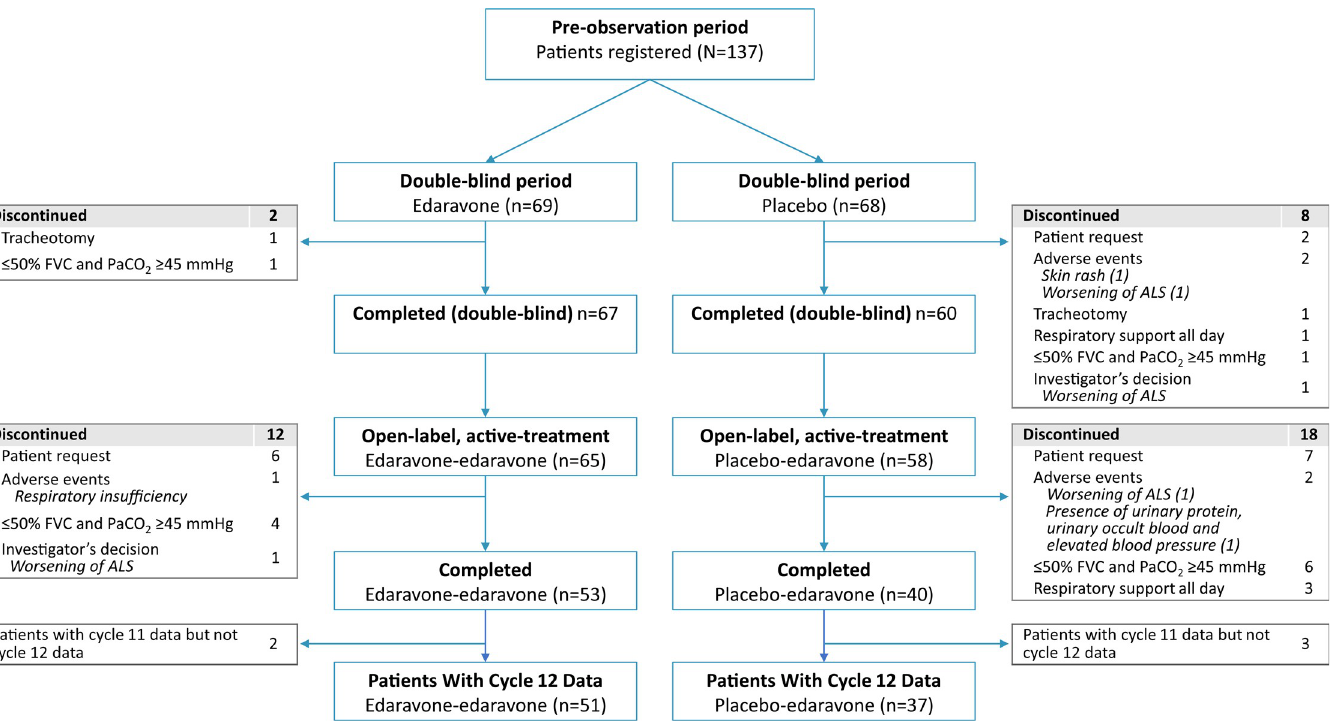
Fig 2. Subject disposition. The diagram shows subject disposition for the various stages of Study 19 and reasons for discontinuation. Note that for the overall study, subjects who returned for follow-up through cycle 11 were considered to have “completed” the study; however, a total of 5 subjects did not have data available for cycle 12 (2 subjects in the edaravone-edaravone group and 3 in the placebo-edaravone group, as indicated in the figure) and those subjects were excluded from the statistical analyses presented in this study. Adapted with permission [19]. ALS, amyotrophic lateral sclerosis; FVC, forced vital capacity (% of predicted); PaCO 2 , partial pressure of carbon dioxide in arterial